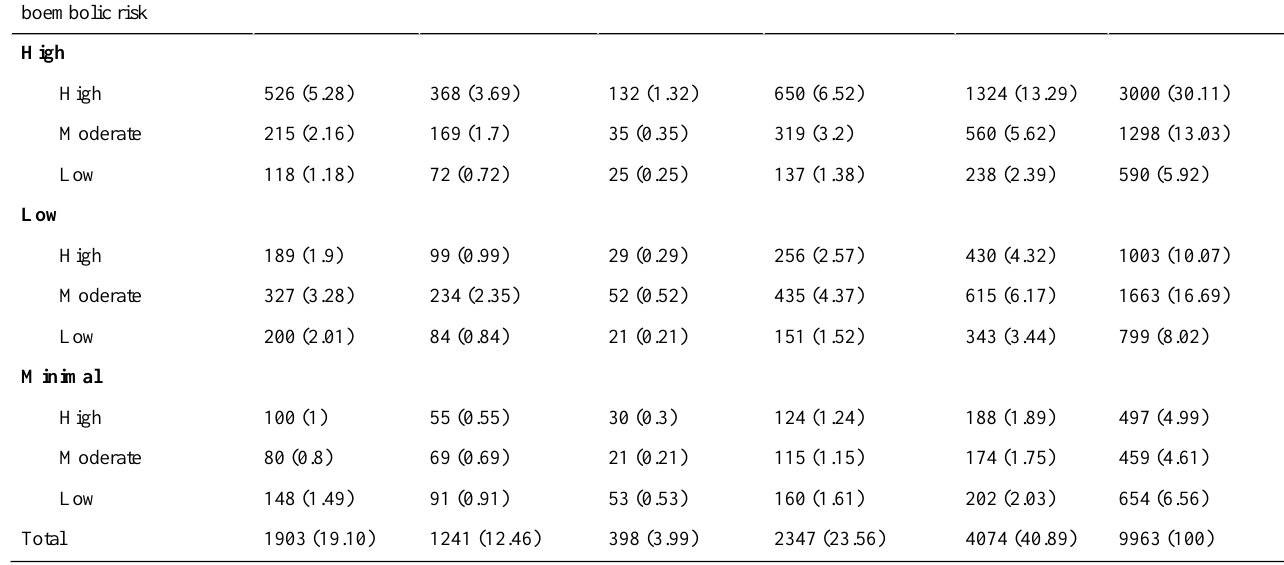
Table 2. Details of completed episodes of use